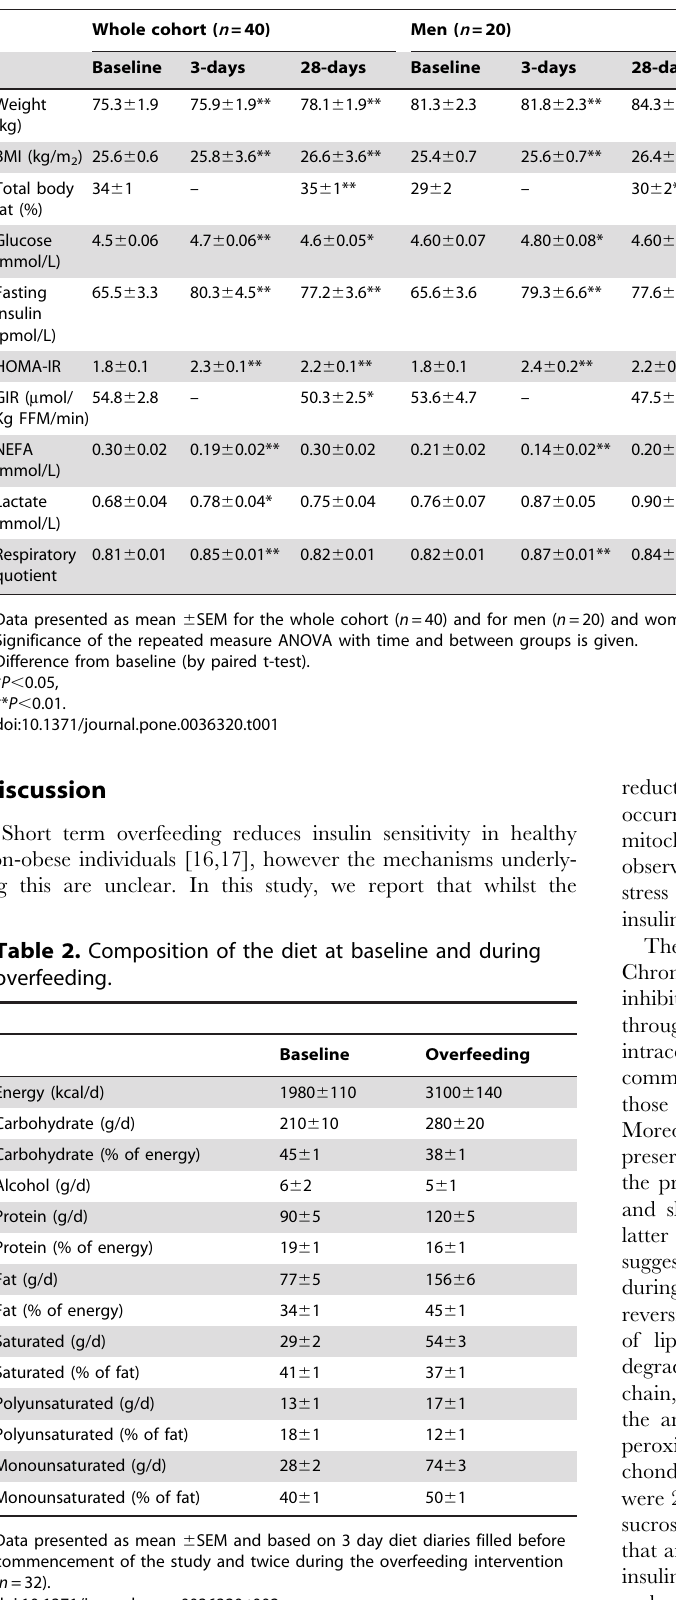
Table 1. Anthropometric and metabolic responses to overfeeding in the whole cohort and in men and women.